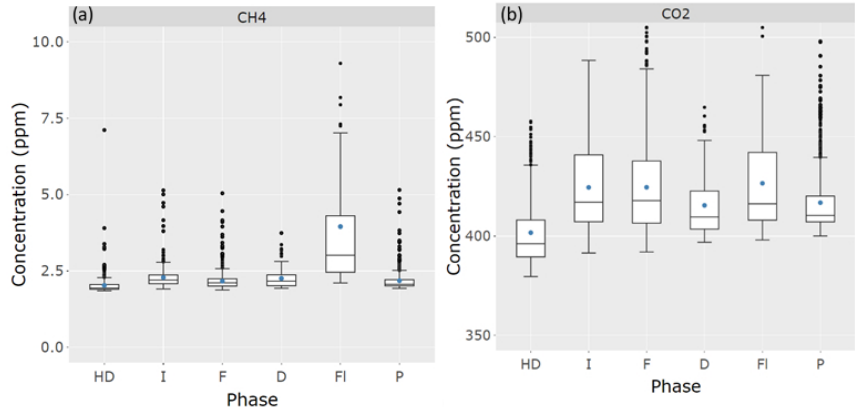
Figure 5. Summary statistics of input parameters for methane (a) and carbon dioxide for (b) HD, horizontal drilling; I, idle; F, fracturing; D, drillout; Fl, flowback; and P,